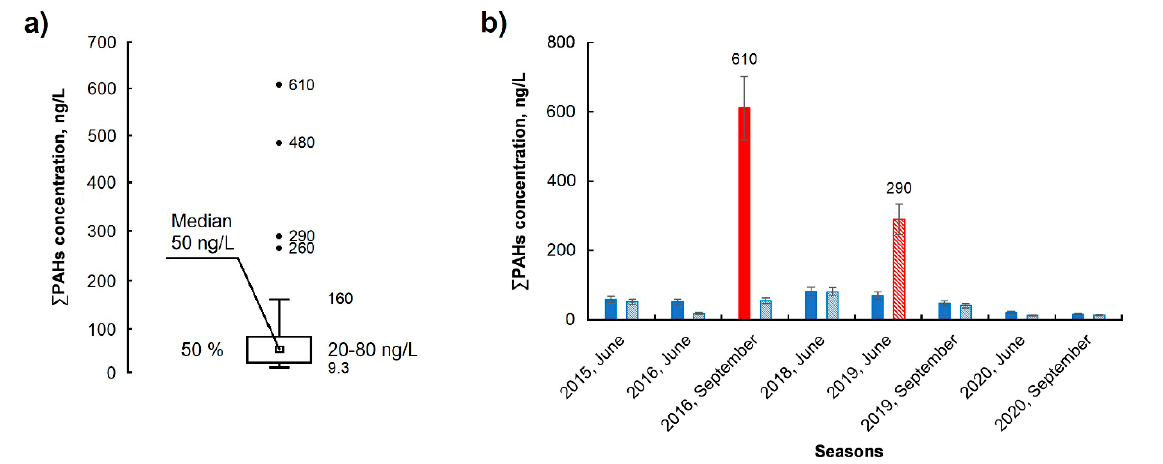
Figure 2. PAH concentrations in water from the pelagic zone of Lake Baikal : ( a ) Box plot of the Ʃ PAHs concentrations; ( b ) Mean concentrations of Ʃ PAHs in the upper water layer (5 m) of the pelagic zone in Lake Baikal: - southern basin, - northern basin. The extreme concentrations of Ʃ PAHs recorded in September 2016 , and June 2019 .